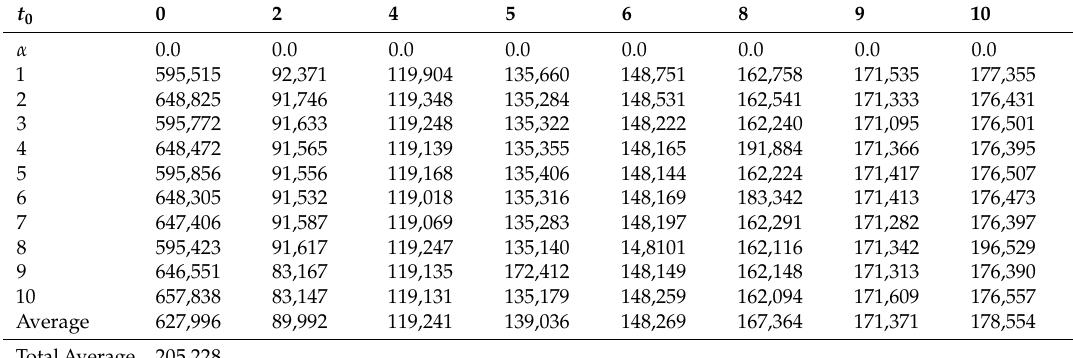
Table 2. Running time for different initial values of Example 1 by our method with test point p = (2.0, 2.0, 2.0).